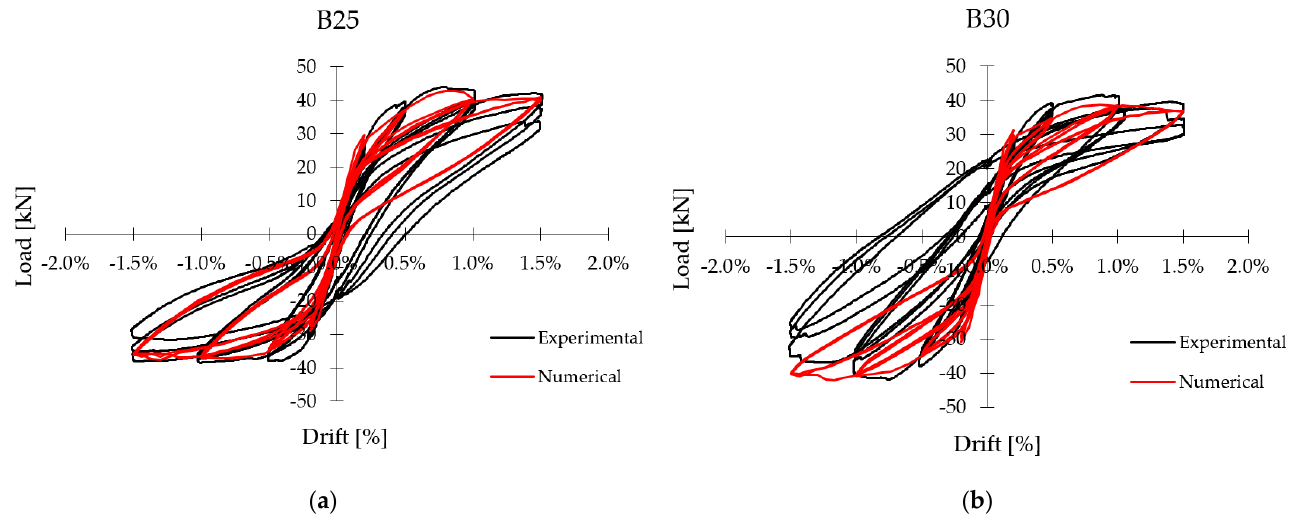
Figure 16. Comparison between experimental and numerical response, corroded specimens, MS 4. ( a ) column B25, ( b ) column B30.